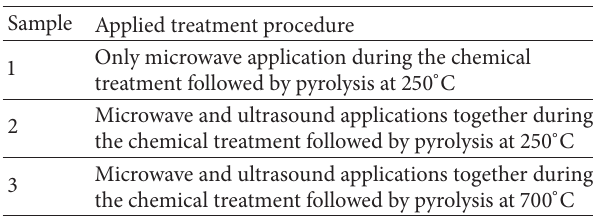
Table 3: Description of the numbers in Figure